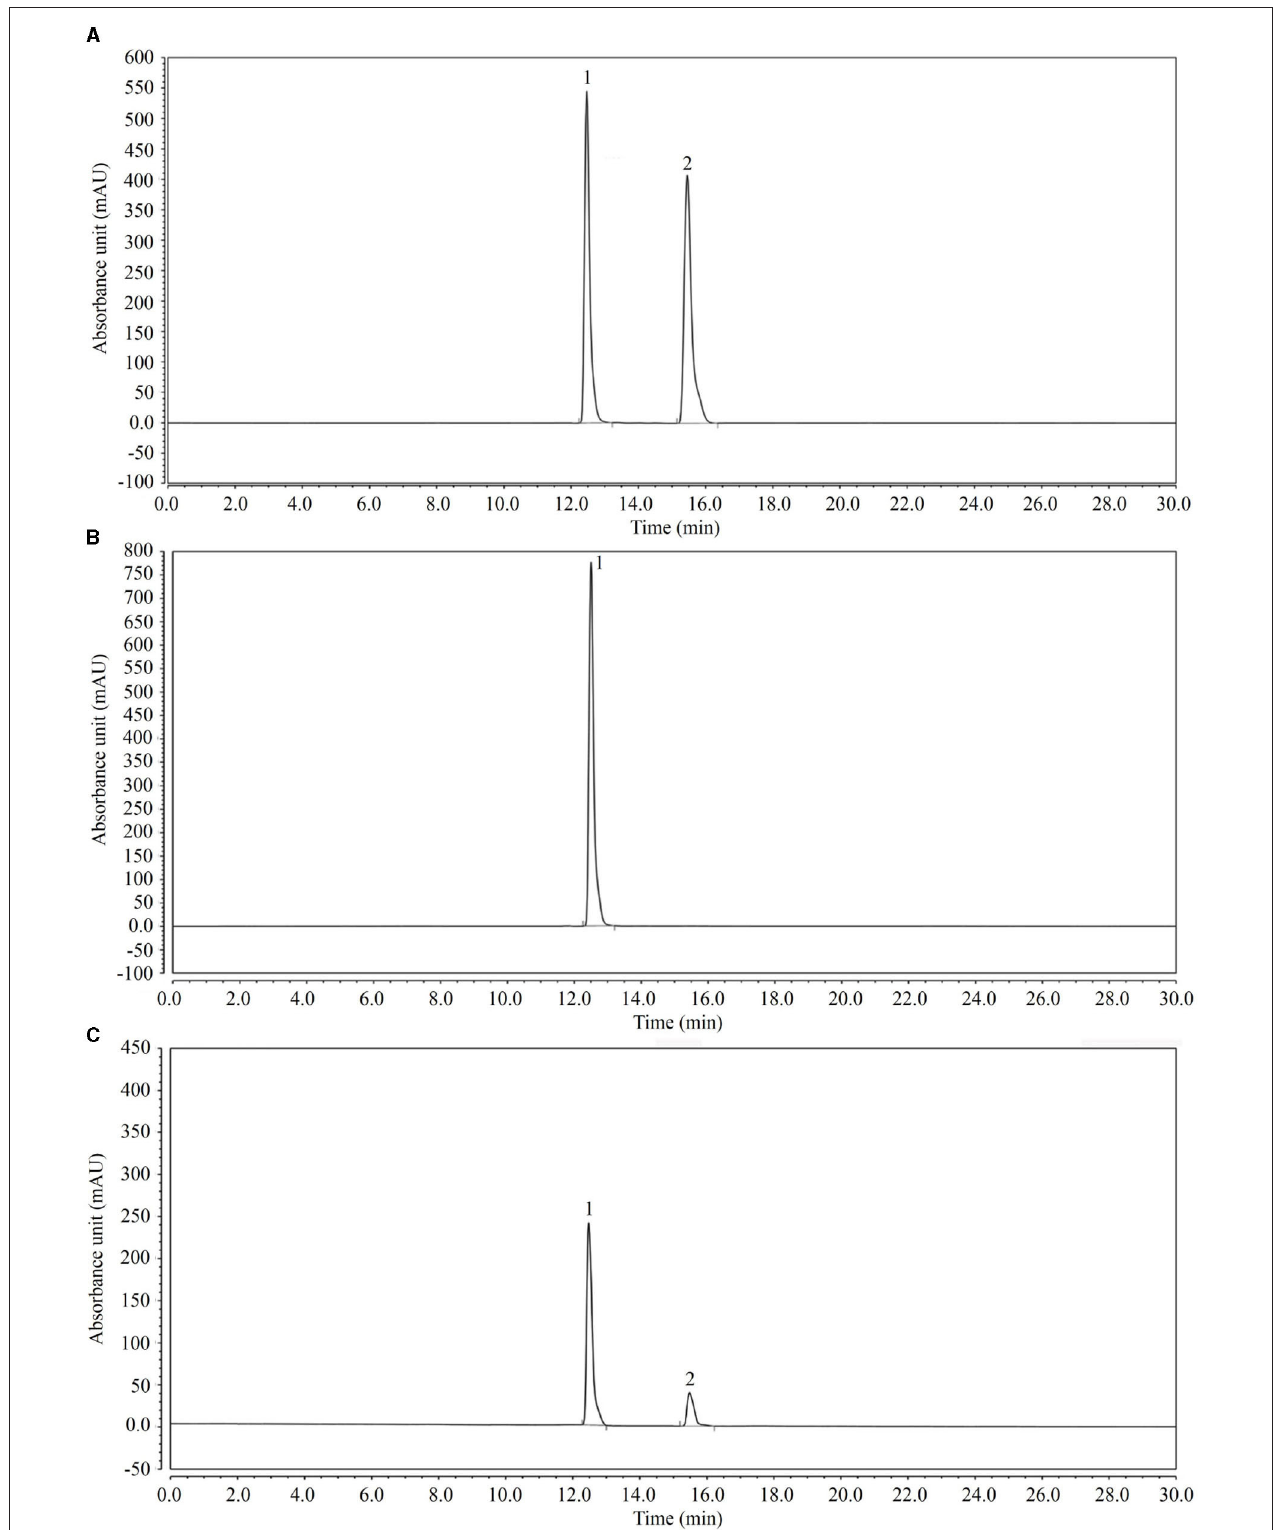
FIGURE 8 | High-performance liquid chromatography (HPLC) analysis of the transformation experiment of geniposide to genipin by LcS. (A) Standards of geniposide and genipin; (B) geniposide and LcS reacted for 0h; (C) geniposide and LcS reacted for 12h. 1: geniposide, 2: genipin.